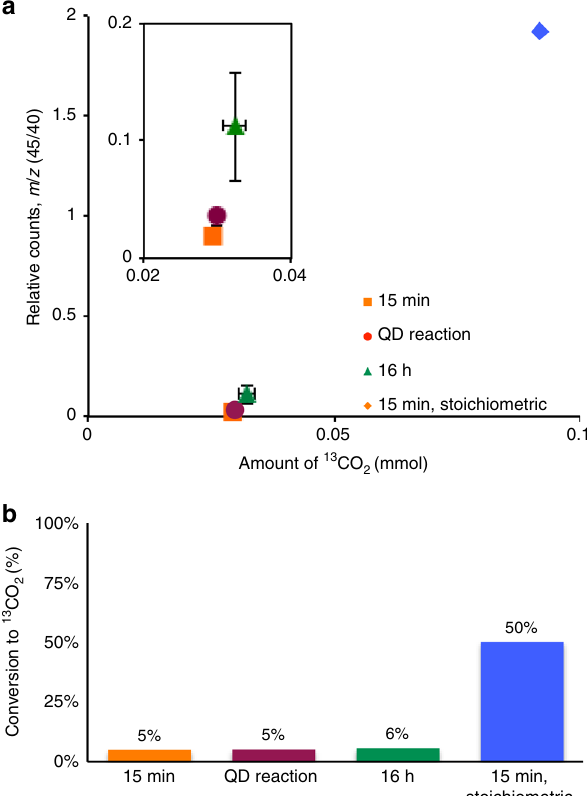
Fig. 5 Detecting 13 CO 2 from cadmium octanoate decomposition. a Headspace samples from different reaction conditions and the amount of 13 CO 2 detected, the calibration curve to which these values are Supplementary Fig. 20. b Bar graph of calculated percent conversion of cadmium carboxylate to 13 CO 2 during the decomposition reaction. Samples compared include the headspace from; a Se-free decomposition with 12 times excess carboxylic acid after 15 min, a QD reaction, a Se-free decomposition with stoichiometric amounts of carboxylic acid after 15 min (QD absorbance spectrum in Supplemental Fig. 21, and a Se-free decomposition with excess carboxylic acid after 16 h. Tabular data can be found in Supplemental Table 2. Error bars depict the standard error of the mean of fi ve replicate